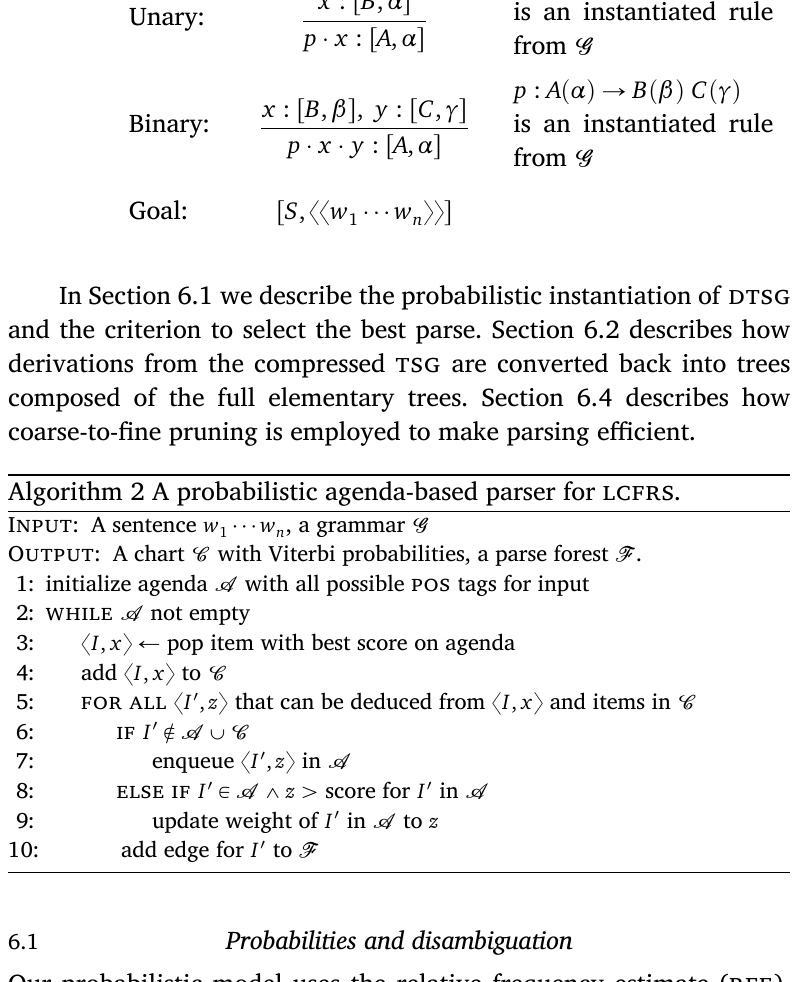
Figure 14: Weighted deduction system for binarized lcfrs